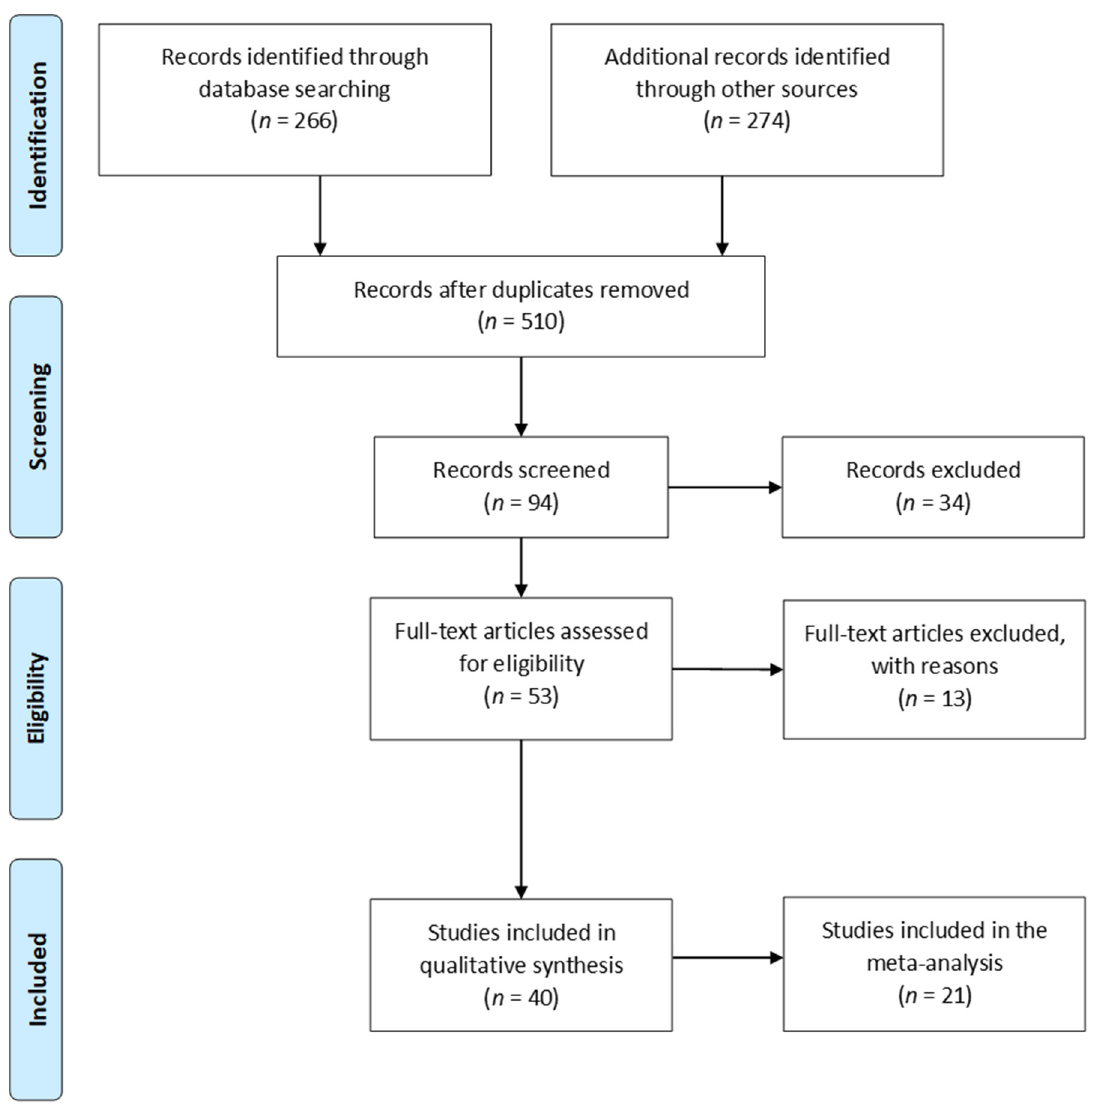
Figure 1. Flow chart presenting the process of searching for eligible articles according to PRISMA guidelines.